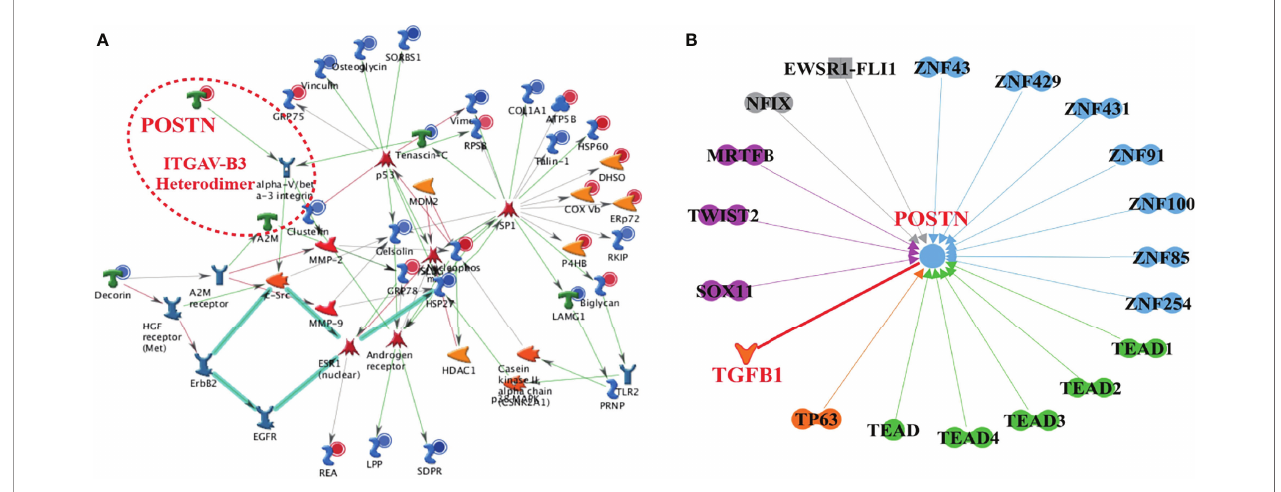
FIGURE 3 | The high-con fi dence networks of POSTN were constructed by multiomics. (A) The top 1 enrichment network of Metacore ™ . The ITGAV-B3 heterodimer presented integrin a V b 3. (B) The interaction network of POSTN by IPA. Dumbbell shape: transcription regulator; boomerang shape: growth factor; the arrow direction: